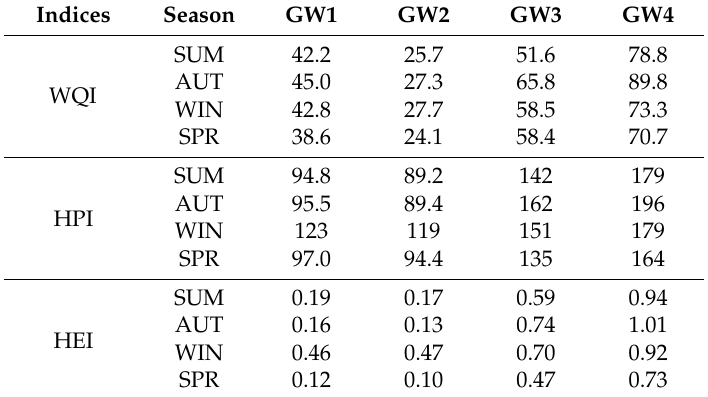
Table 5. The WQI, HPI, and HEI results calculated for all four seasons.